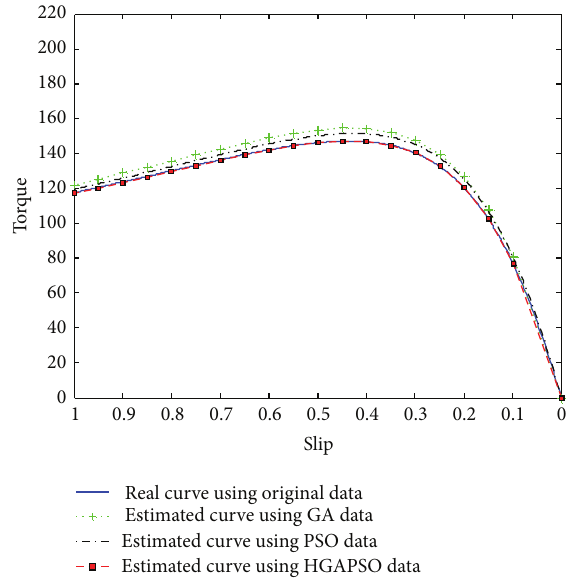
Figure 4: The torque versus slip curve using GA, PSO, and HGAPSO